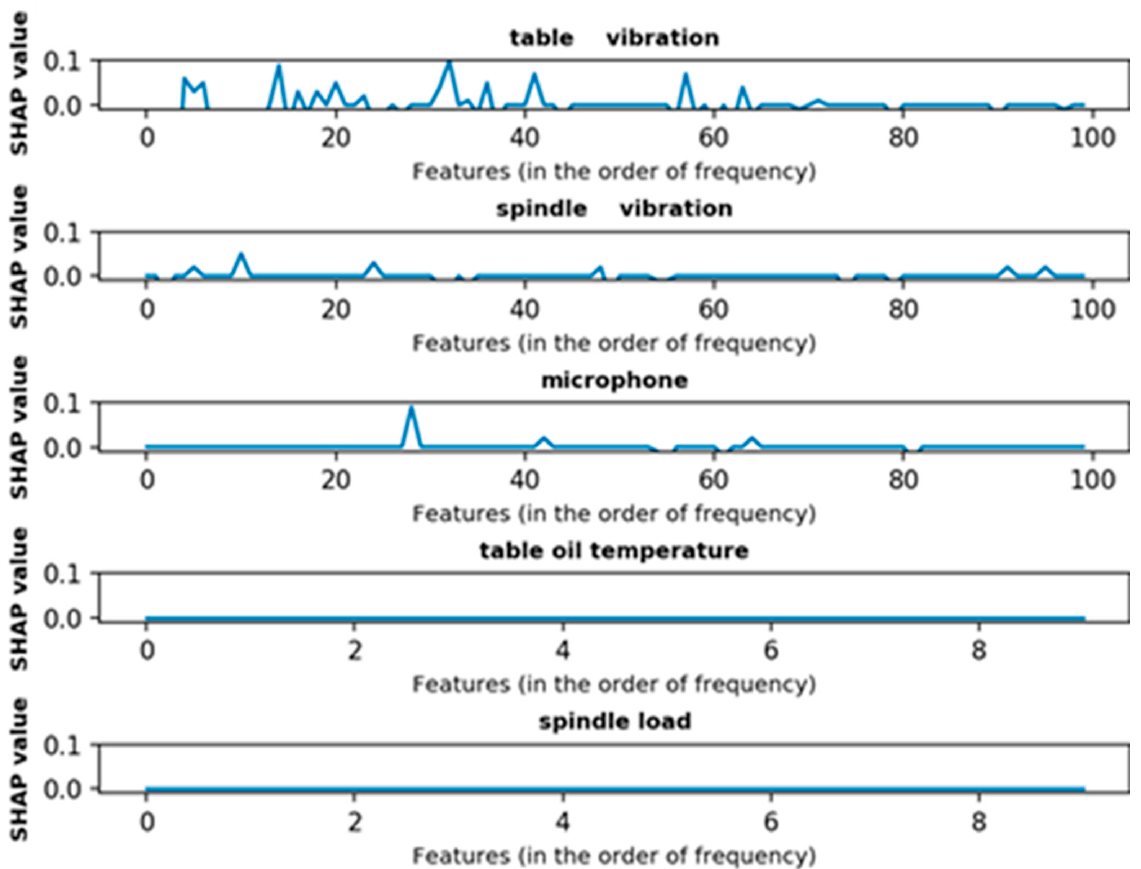
Figure 4. SHAP sum values of signal of each feature.